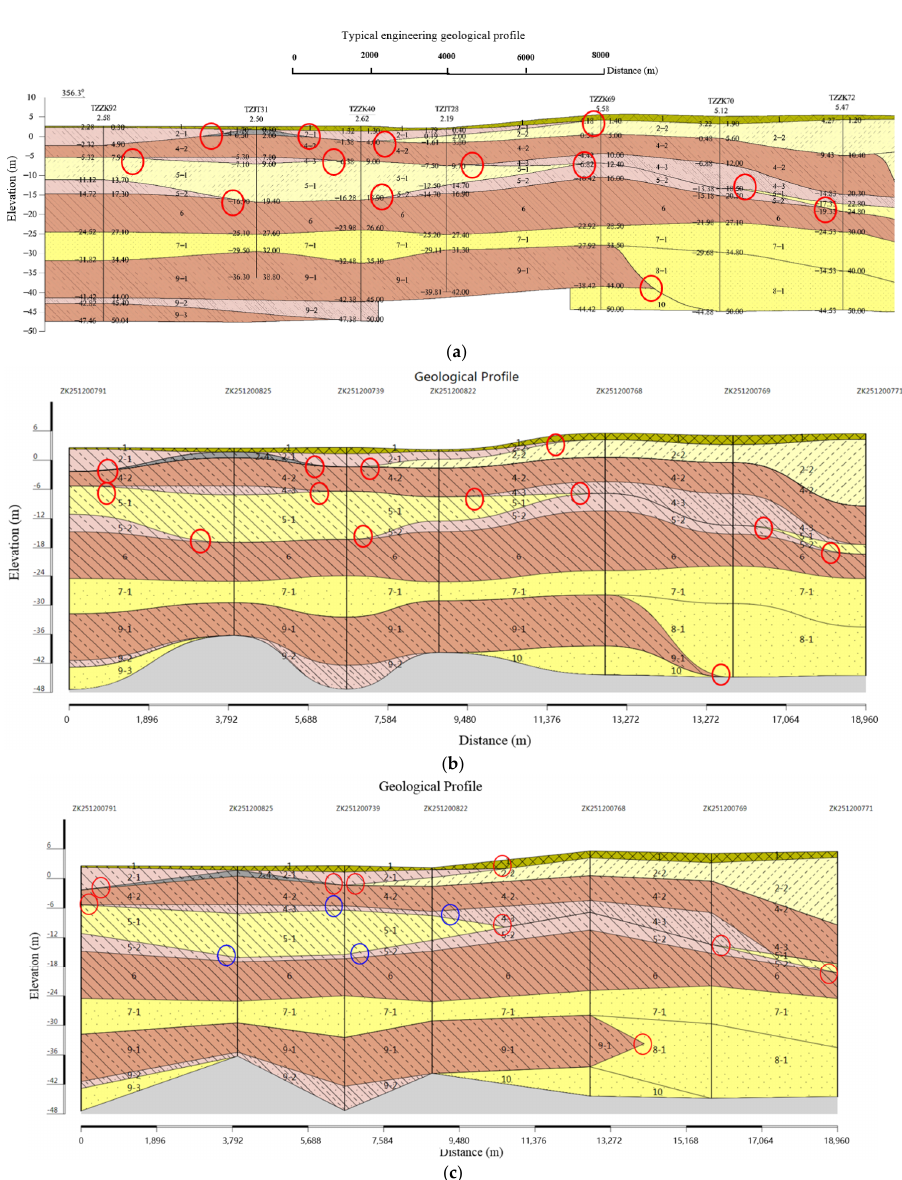
Figure 20. Comparison of engineering geological profiles drawn by different methods. ( a ) Engineering geological profile drawn by the empirical experts; ( b ) engineering geological profile drawn by traditional method, ( c ) engineering geological profile drawn by unique path method.